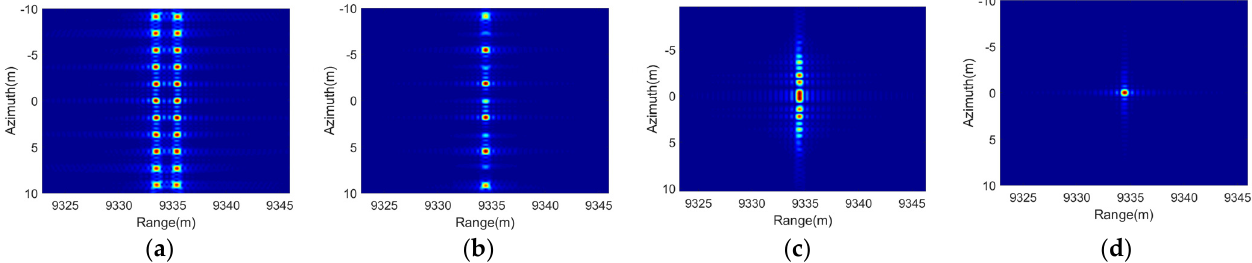
Figure 17. Focusing results of point target with linear oscillation. ( a ) Target oscillates along the range direction, A l = 1 m; ( b ) target oscillates along the range direction, A l = 0.05 m; ( c ) target oscillates along the azimuth direction, A l = 1 m; ( d ) target oscillates along the azimuth direction, A l = 0.05 m.